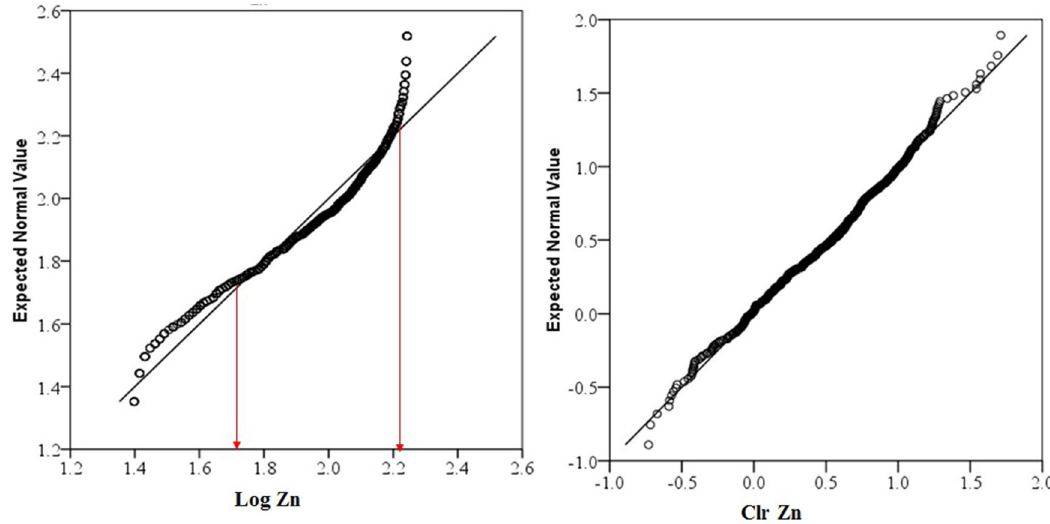
Figure 4. Q–Q PLOT of: (a) Zn original log-transformed data; (b) Zn clr-transformed data.